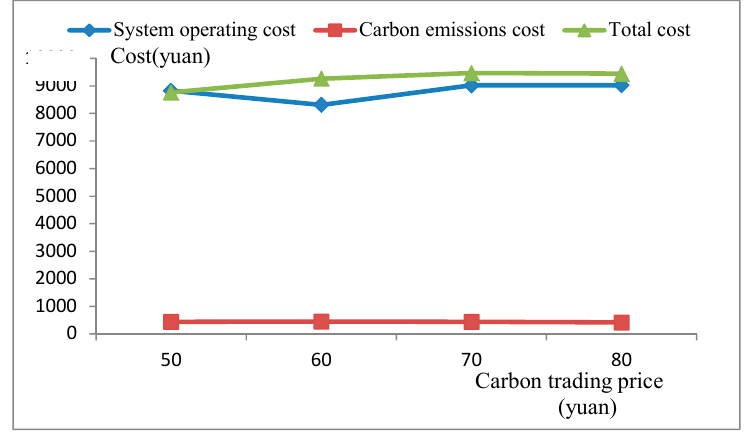
Figure 8. The relationship between carbon trading price and system cost.